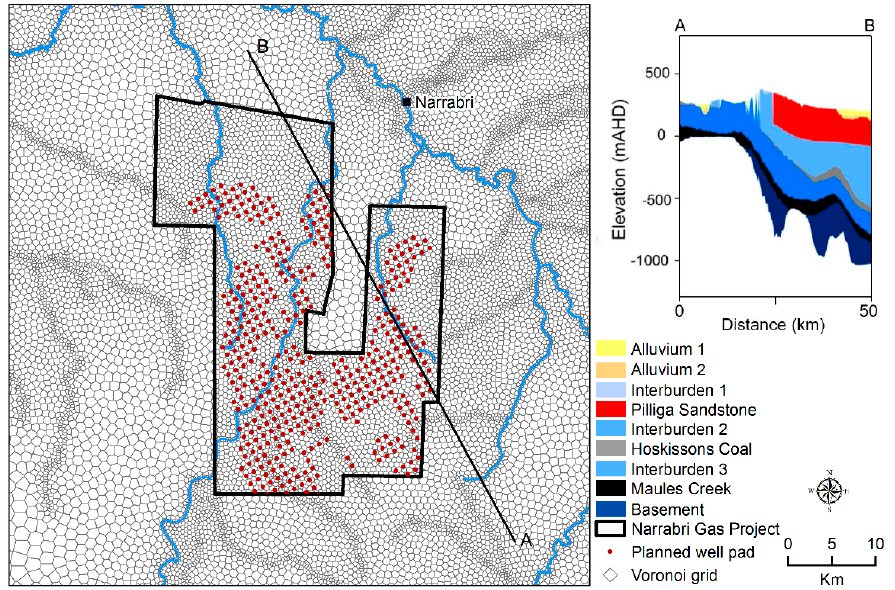
Figure 2. Voronoi model grid structure and hydrostratigraphy of the Narrabri Gas Project area.